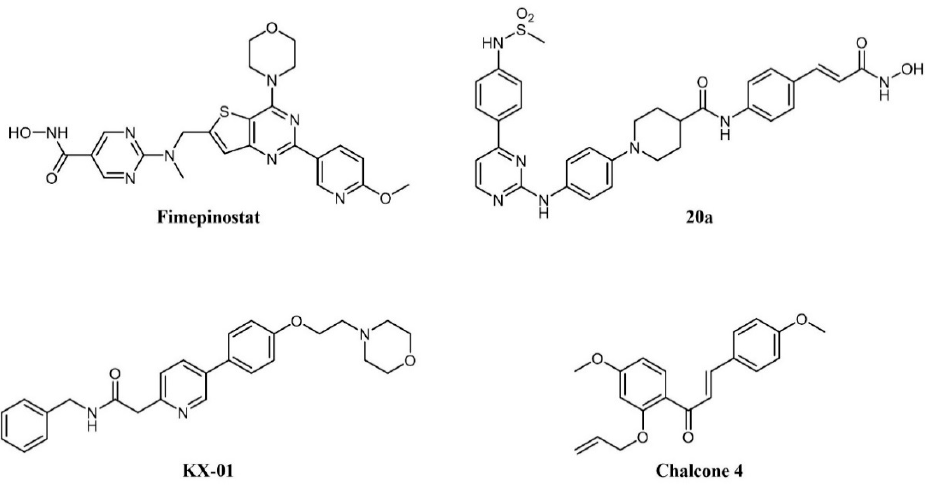
Figure 8. Chemical structure of dual-target kinase inhibitors.